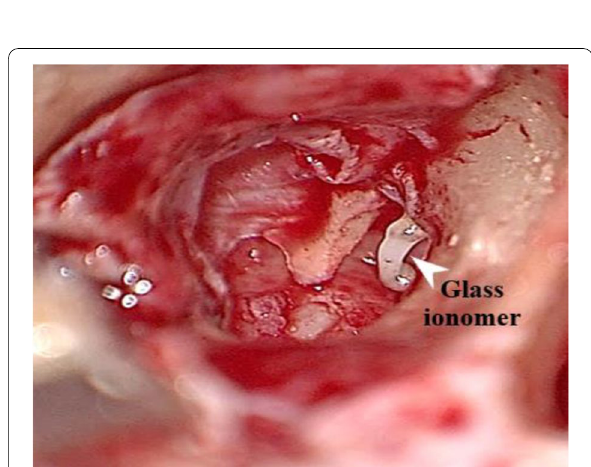
Fig. 3 Glass ionomer bridging the incus and stapes